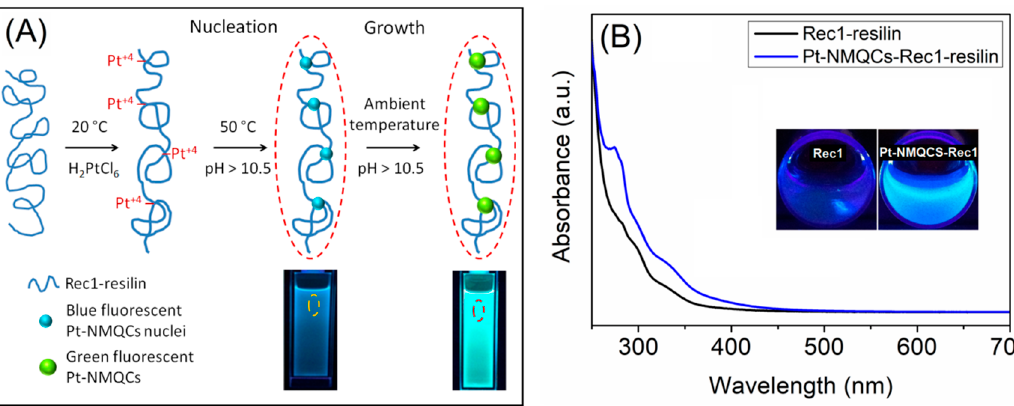
Figure 1. ( A ) Schematic representation of Rec1-resilin-directed ‘green synthesis’ of the fluorescent platinum noble metal quantum clusters (Pt-NMQCs) employed. ( B ) UV-visible absorption spectra of pristine Rec1-resilin (at pH 12) and blue fluorescent Pt-NMQCs-Rec1-resilin nanobioconjugates. Insets are the corresponding optical images of samples under 365 nm UV light.